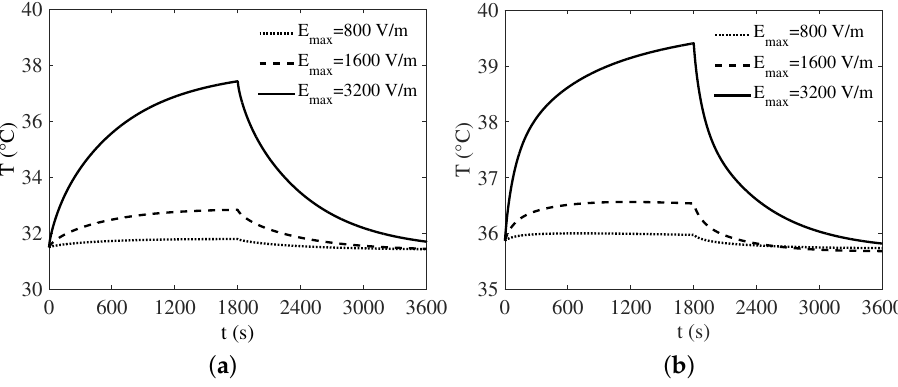
Figure 7. Temperature versus the time for three different PEF amplitudes; ( a ) at the air-skin boundary and ( b ) at the outer surface of the brain